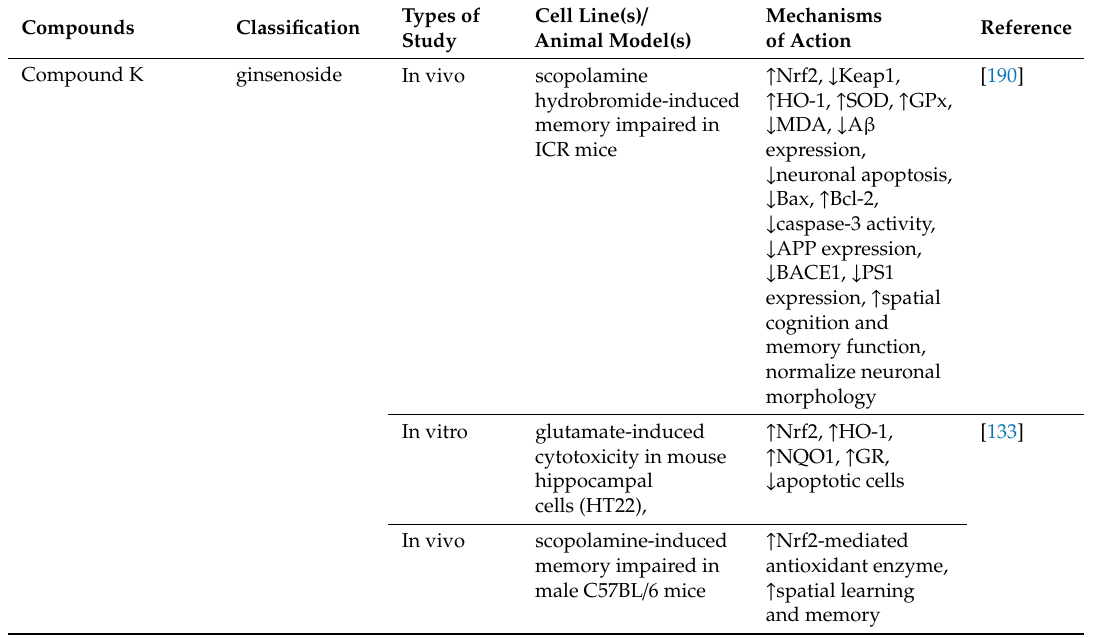
Miscellaneous compounds in combating AD through Nrf2 / Keap1 / ARE and interconnected